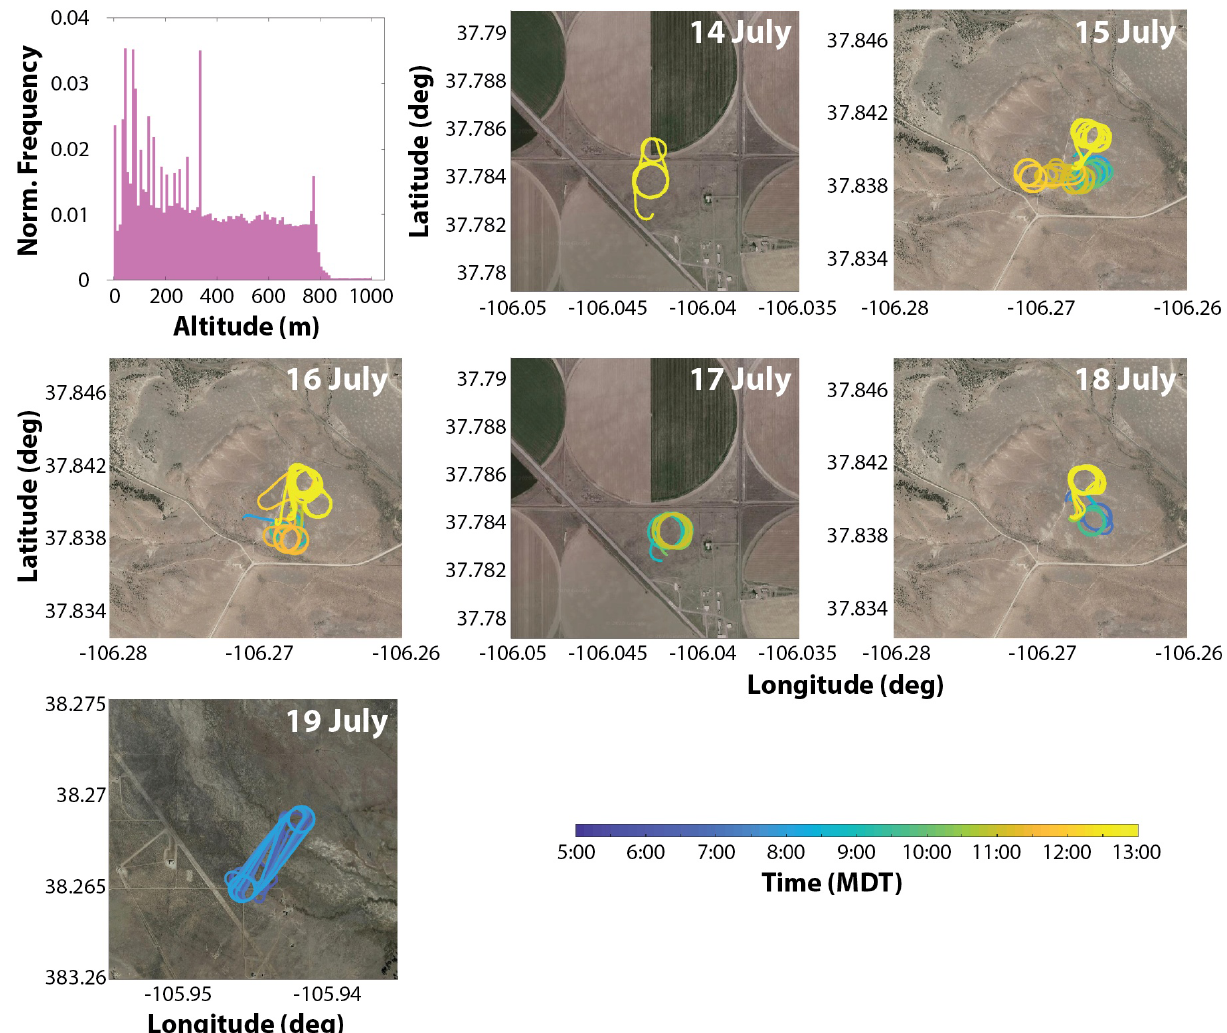
Figure 4. A histogram of altitudes covered during LAPSE-RATE by the S1 (left), along with the flight patterns covered by this aircraft during individual days of the campaign. See the map in Fig. 2 for additional details on flight locations. Map backgrounds are © Google Maps 2021 and downloaded through their API.